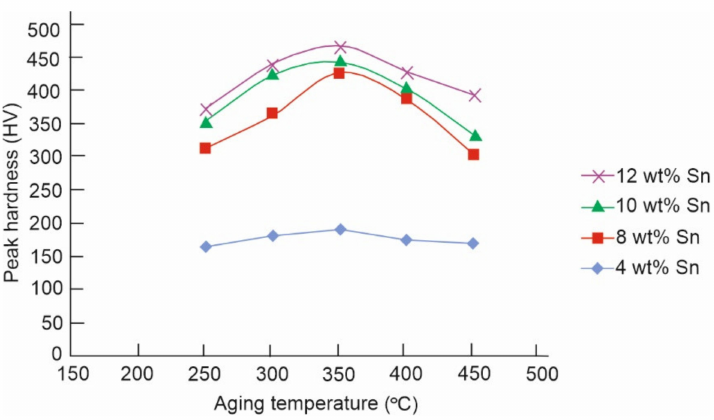
Figure 4. Peak hardness versus ageing temperature